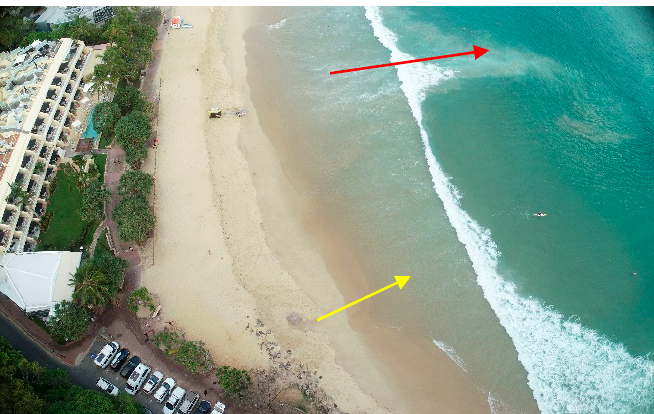
Figure 7. Aerial view of the eastern corner of Noosa Main Beach on 21 February 2019 at 6:19 a.m. with a large rip clearly present (red arrow). The outlet of the sand recycling system is shown (yellow arrow) and is located up-current from the observed rip.